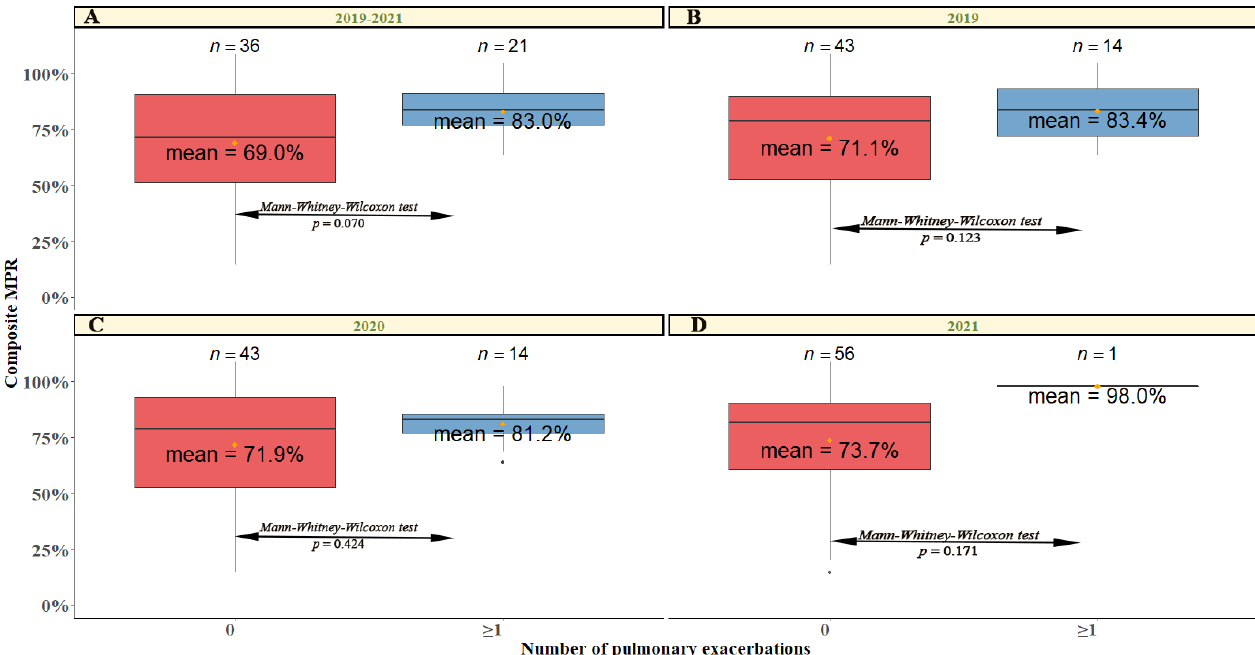
Figure 3. Compliance measured by MPR% for each treatment per year. The test used and the p - value obtained after comparing the groups are indicated above each graph. In those groups where a statistically significant difference ( p < 0.05) was obtained, a post-hoc test was conducted. The type of post-hoc test conducted and the p -value obtained from those statistically significant comparisons are indicated between arrows.